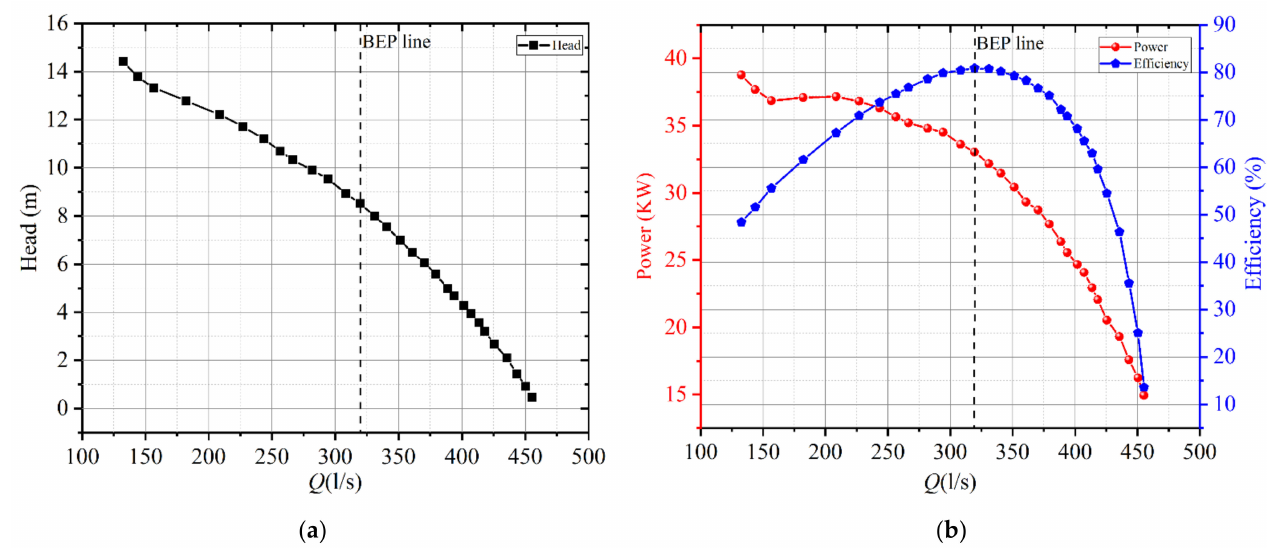
Figure 4. Machine external performance characteristics ( a ) H-Q curves ( b ) η -Q